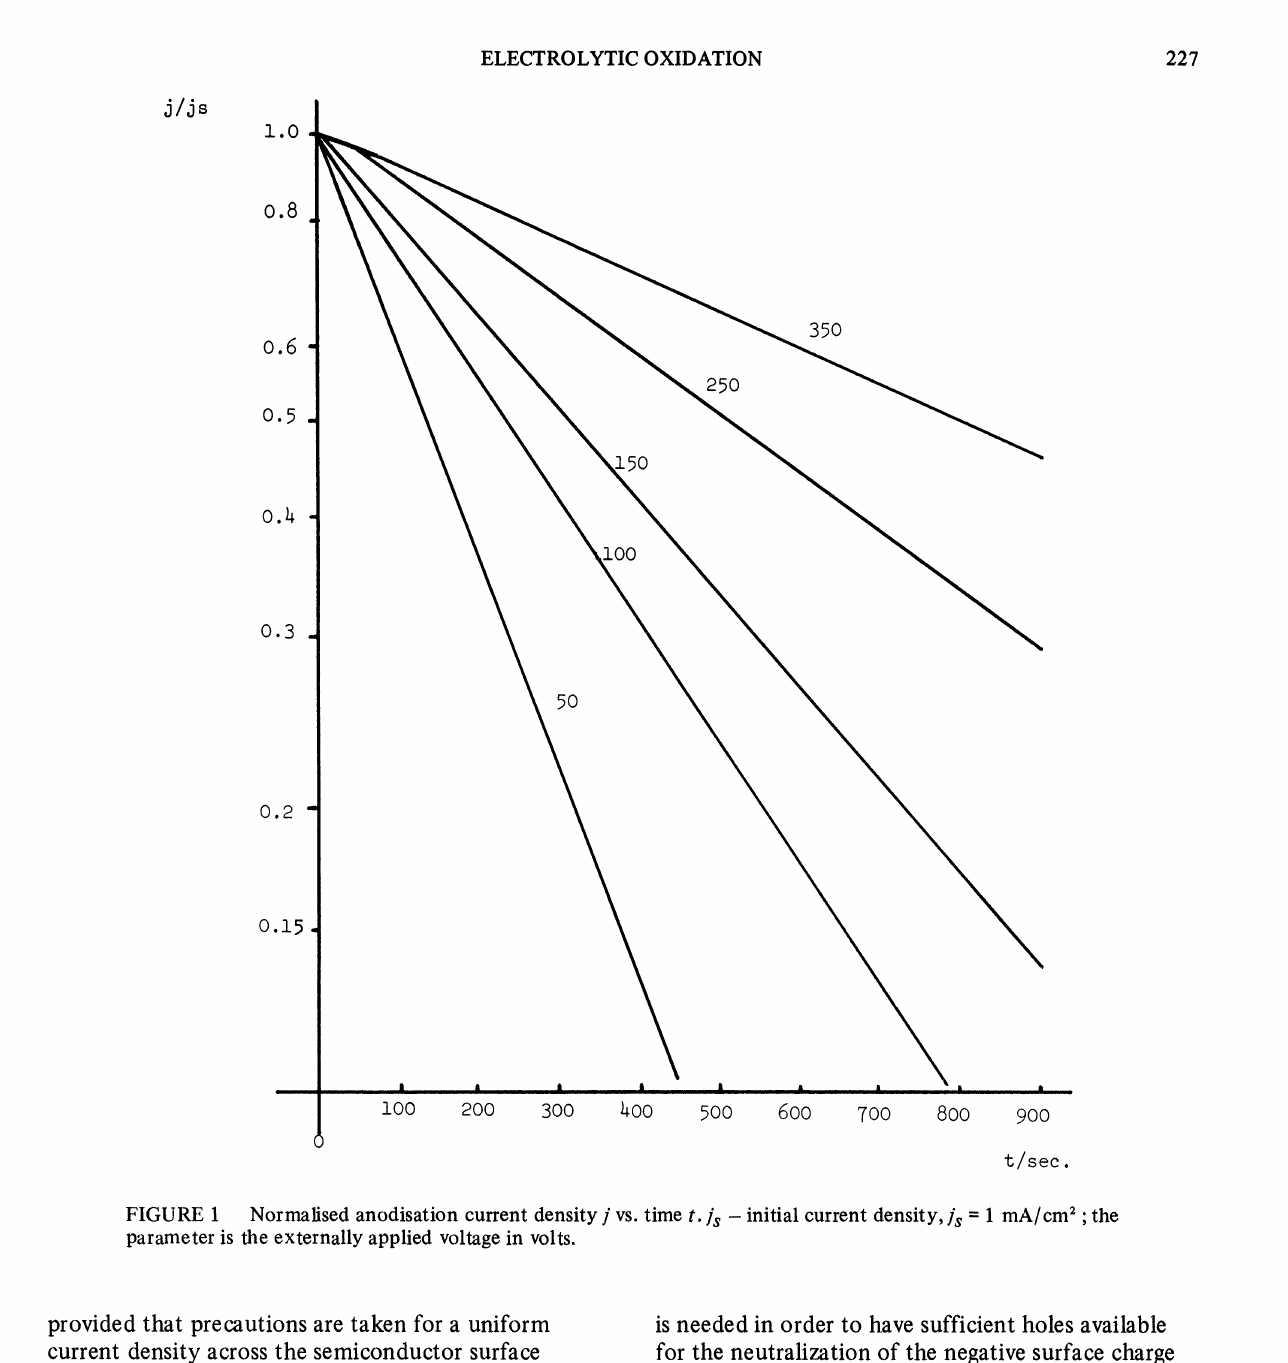
Normalised anodisation current density ] vs. time t. is initial current density, is mA/cm the parameter is the externally applied voltage in